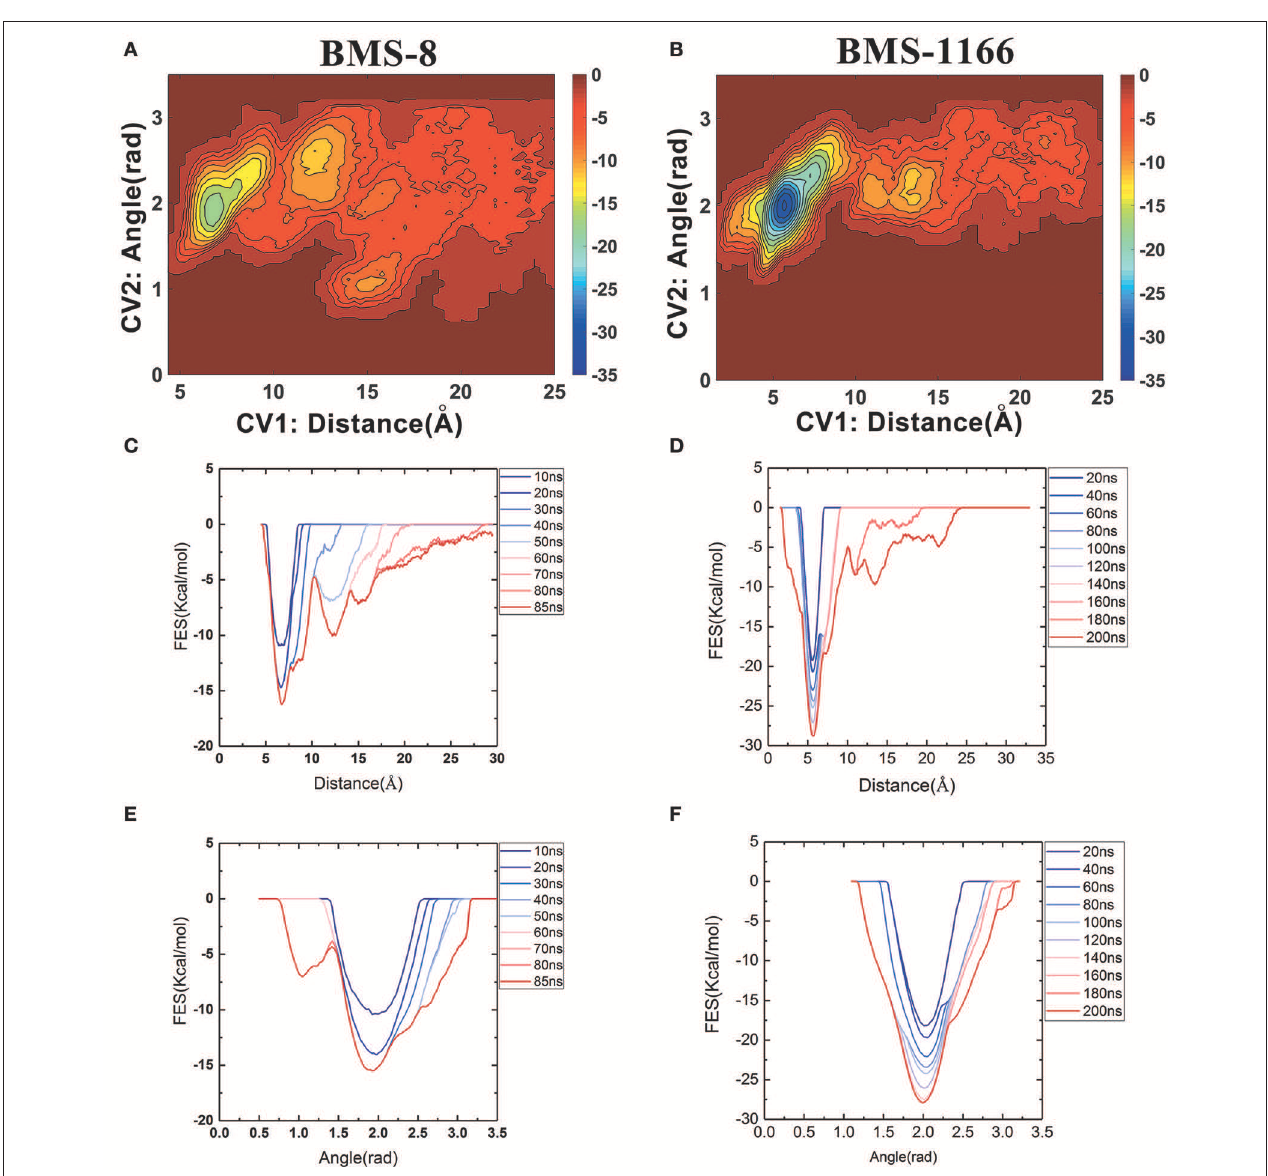
FIGURE 6 | The energy change during the unbinding process. (A,B) The free energy landscapes for the unbinding process of BMS-8 and BMS-1166. (C–F) The convergence of sampling process during the unbinding process of BMS-8 and BMS-1166. The history-dependent free energy surfaces along CV1 (C,D) and CV2 (E,F) are estimated by a segmented accumulation of simulation time. The unit for the free energy is kcal/mol.